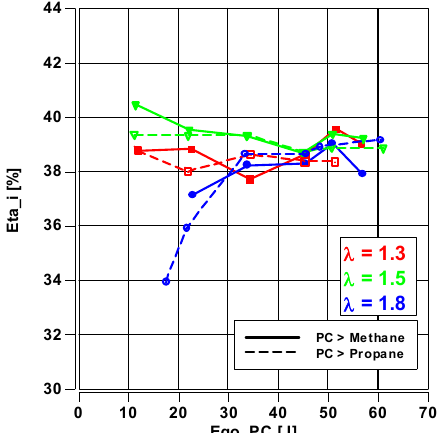
Figure 14. Indicated engine efficiency related to the value of energy supplied to the prechamber during the combustion of methane and propane.